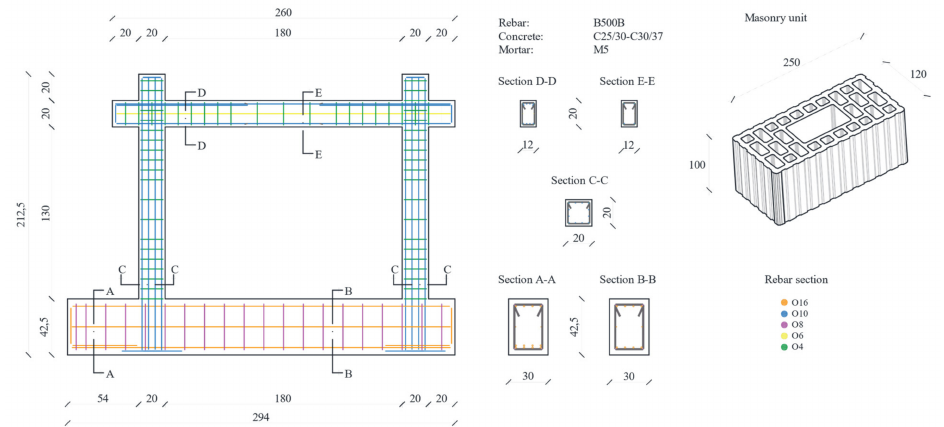
Figure 1. Specimen’s properties.